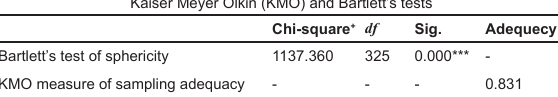
Table 1 Demographic information of the sample